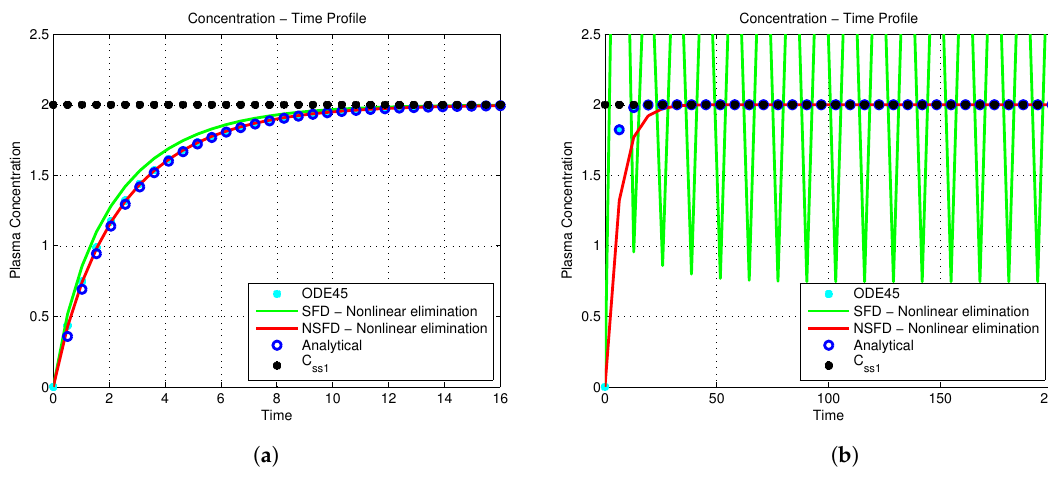
Figure 9. NSFD (50) scheme, SFD scheme (49) and ODE45 are compared analytical solution (45). C ss 1 is the steady state Equation (48). The concentration of the drug when administered via I.V. bolus infusion and eliminated by nonlinear pharmacokinetic processes for ( a ) h = 0.51613 and ( b ) h = 6.4516.